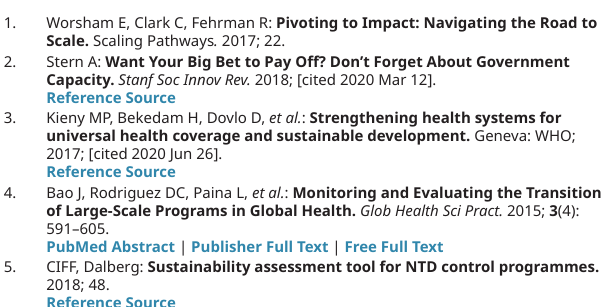
Figshare: Interview Write Up Template for Accompanying